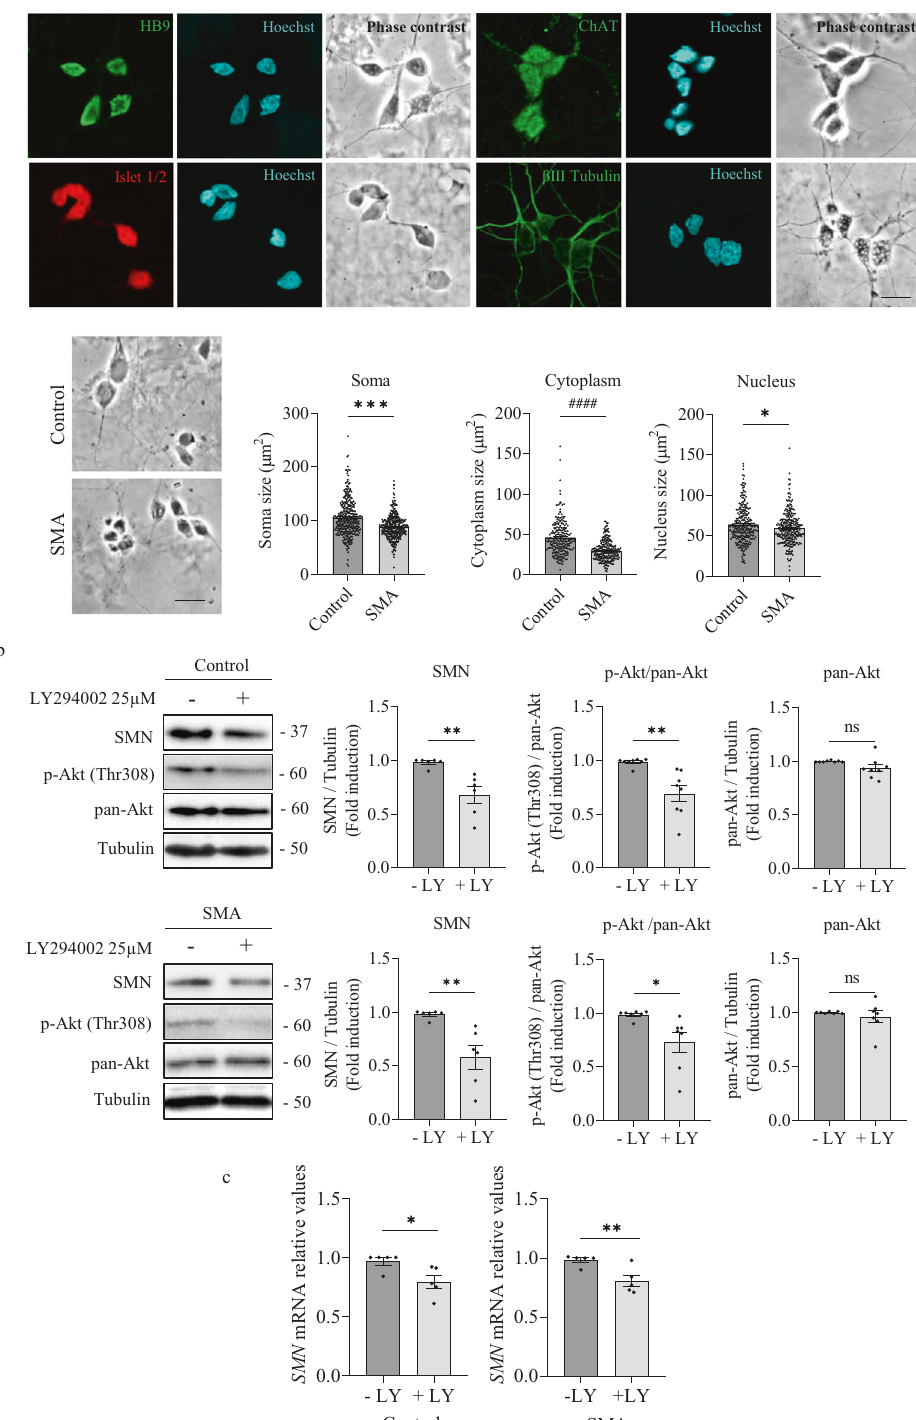
signi fi cantly reduced p62 and LC3-II protein levels, compared to their untreated controls (p62: SMA -U0: 1.667 ± 0.26; SMA + U0: 0.943 ± 0.04, p = 0.024; LC3-II: SMA -U0: 2.53 ± 0.66; SMA + U0: 0.606 ± 0.094, p = 0.0259). However, Control cultures showed no differences in p62 and LC3-II protein levels in U0126-treated ( + U0)